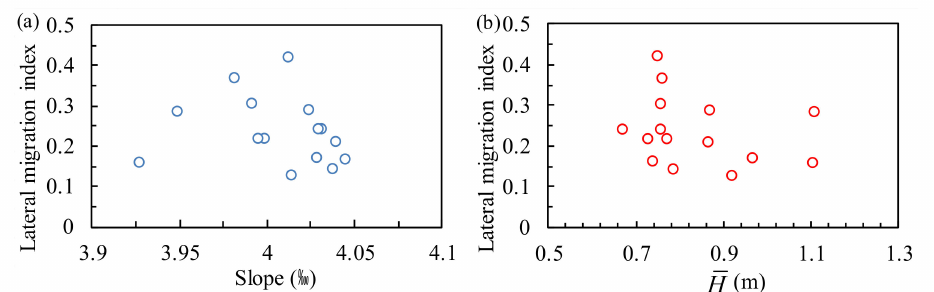
Figure 9. Relationships between the lateral migration index and other boundary conditions of ( a ) channel slope; ( b ) elevation di ff erence between floodplain and main